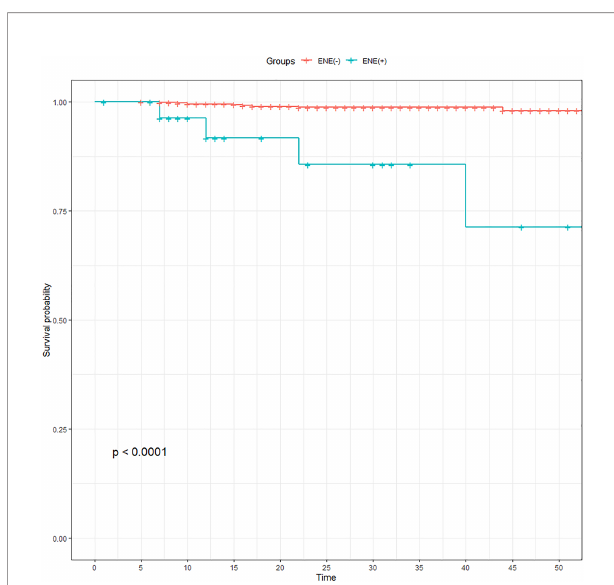
FIGURE 3 | Comparison of recurrence-free survival of PTC patients before propensity score matching. ENE, extranodal extension; PTC, papillary thyroid